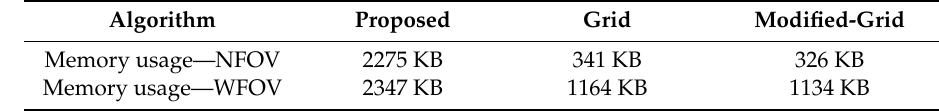
Table 13. Summary of average memory requirements for narrow and wide